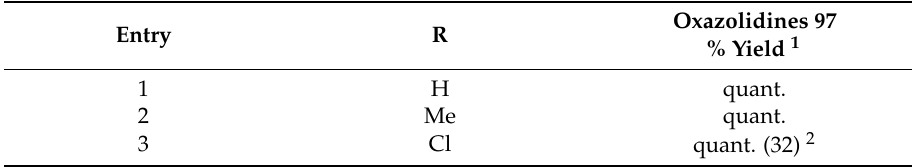
Table 13. Cycloaddition of excess azomethine ylide 81 to 3-cyanochromones 96 (Scheme 22). Entry R